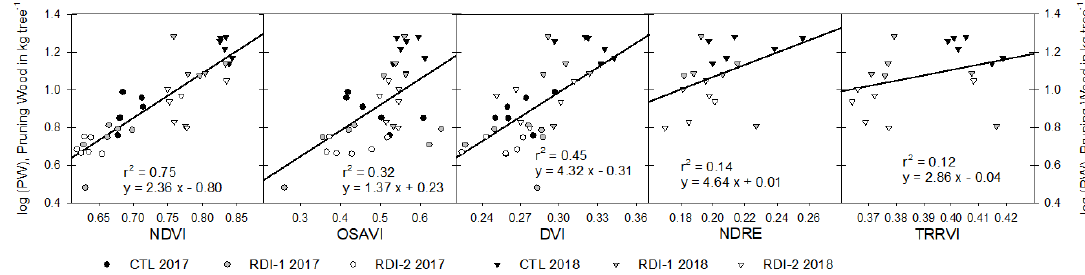
Figure 7. Linear relationships between the logarithm of the pruning wood mass (log (PW)) and postharvest values of remote indicators NDVI (normalized difference vegetation index), OSAVI (optimized soil adjusted vegetation index), DVI (difference vegetation index), NDRE (normalized difference red edge), and TRRVI (transformed red range vegetation index).